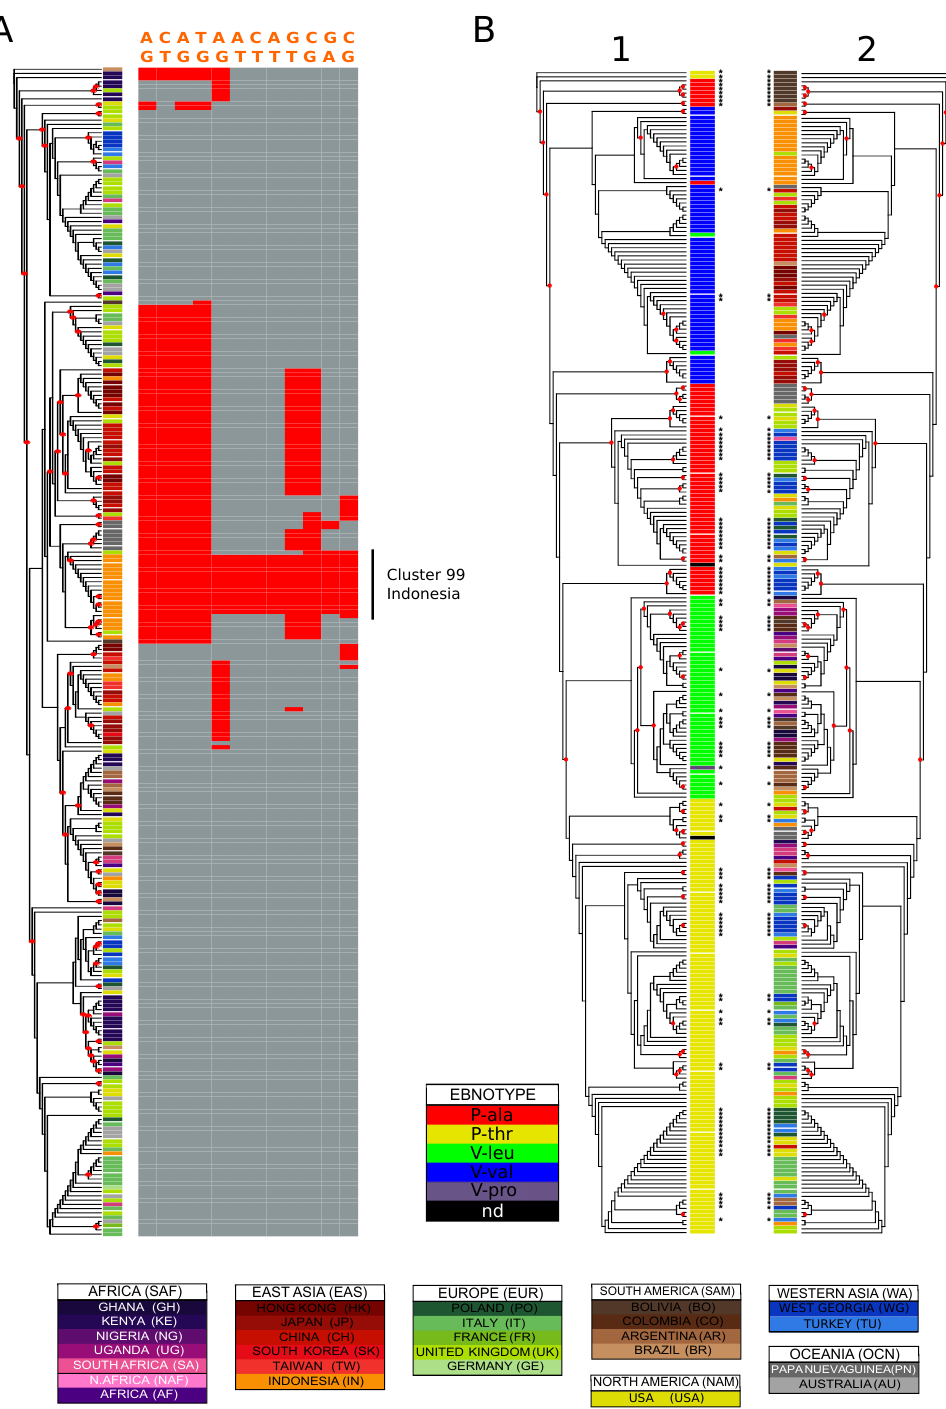
Figure 4. Variation distribution examples. ( A ) characterization of genetic variation in a cluster: Indonesia in EBNA-3C type 1. EBNA-3C type 1 phylogenetic tree coloured by country of origin. The asterisks identify sequences added in this study. The variation of 14 polymorphisms highly enriched in the purely Indonesian cluster number 20 (optimal clustering against country of origin) is shown on the right of the tree. The variant positions relative to the reference sequence are: 86143, 86160, 86212, 86233, 86894, 86926, 86927, 86938, 87557, 88122, 88233, 88901. ( B ) Variation in EBNA-1. EBNA-1 maximum likelihood phylogenetic tree with labels coloured by ( 1 ) ebnotype ( 2 ) country of origin. Four isolates with poor alignment around the codons translating for the typing residues were excluded from the analysis. The asterisks identify sequences added in this study, and the red circles nodes with bootstrap values higher than